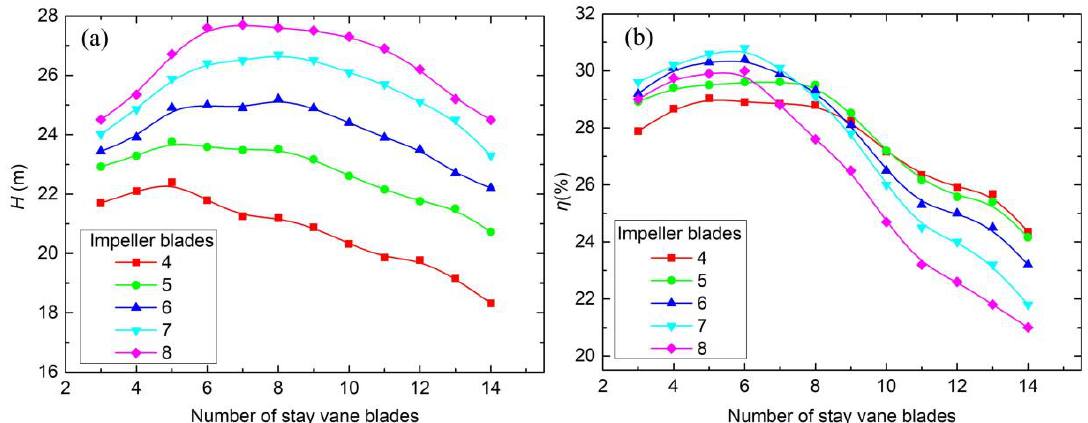
Figure 9. ( a ) Head and ( b ) efficiency under a different number of stay vane blades.